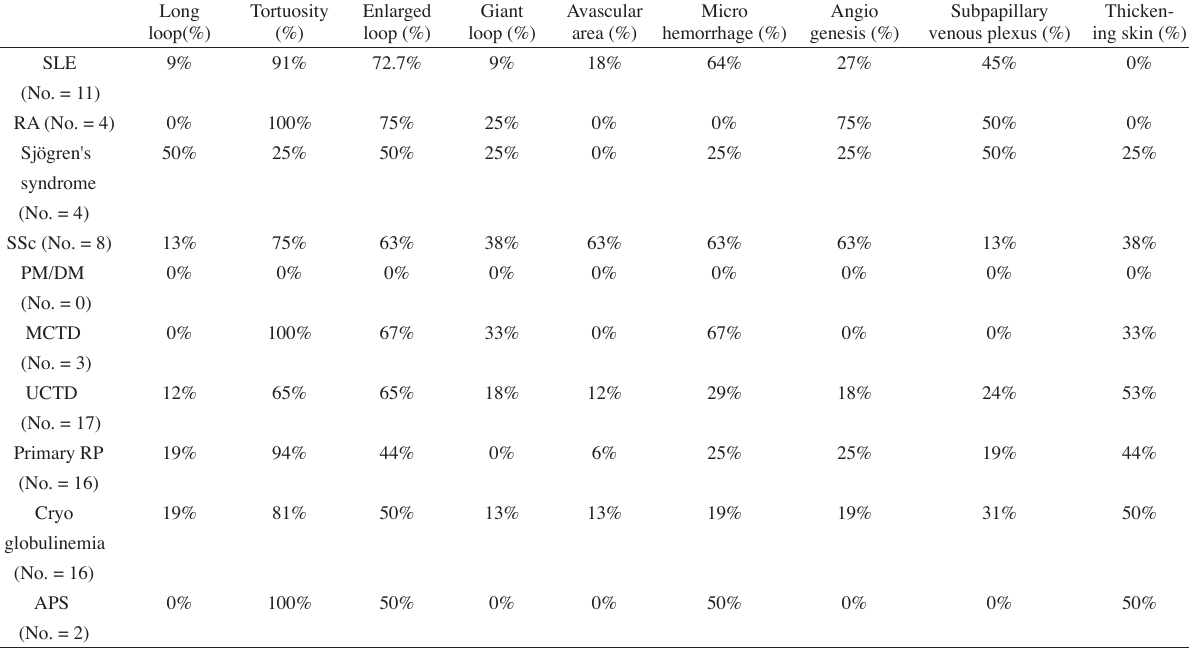
Table 3. Frequencies of capillaroscopic patterns in rheumatic diseases with RP in authors' hospital Long Tortuosity